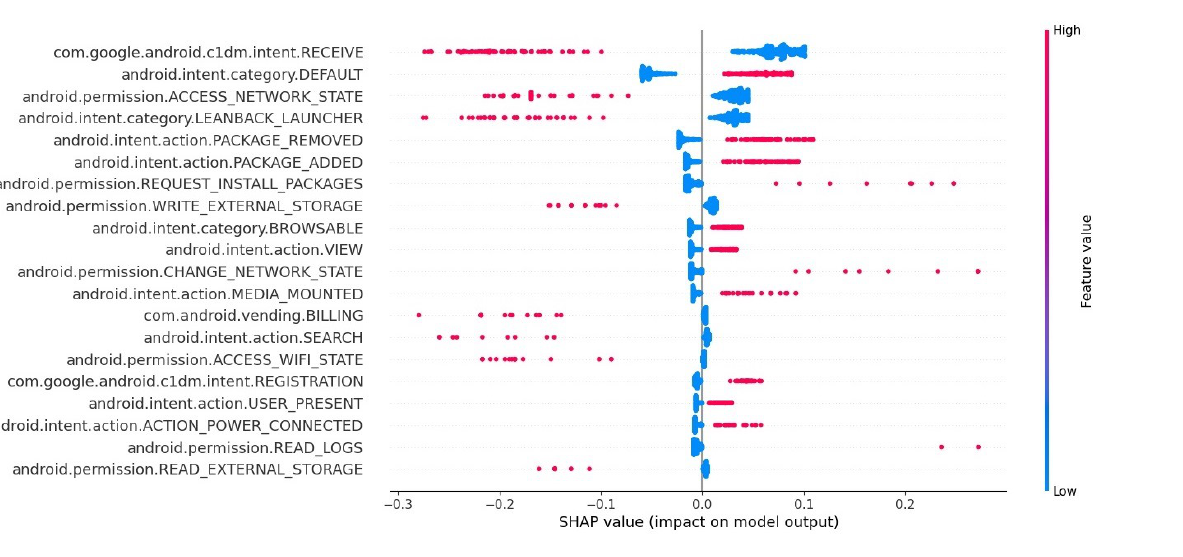
Figure 14. Heatmap of the input features for the DNN